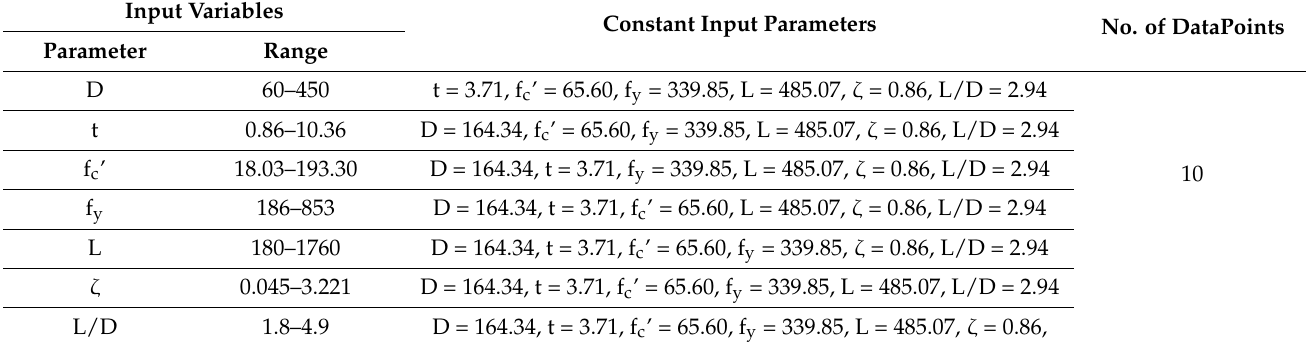
Table 7. Dataset used for parametric